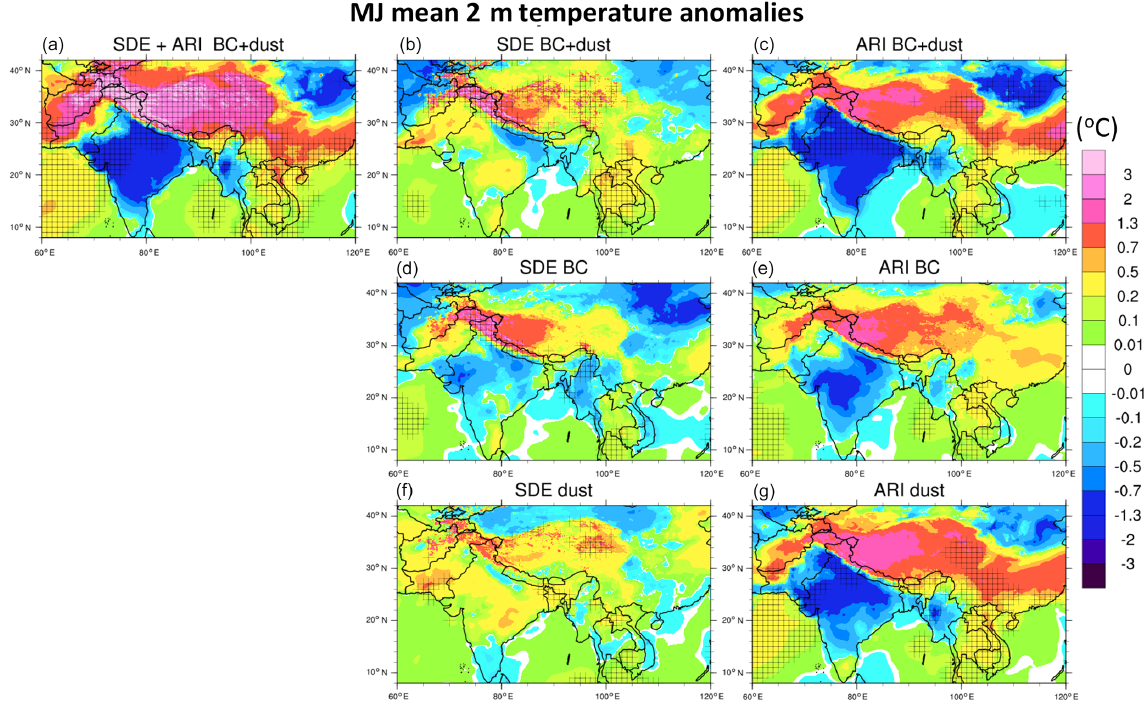
Figure 6. May–June mean 2m temperature ( T 2) anomalies ( ◦ C) due to (a) BCD-induced SDE + ARI, (b) BCD-induced SDE, (c) BCD- induced ARI (d) BC-induced SDE, (e) BC-induced ARI, (f) dust-induced SDE, and (g) dust-induced ARI. Hatching marks denote areas with t values of 0.9 and greater, which have been interpolated to a 1 ◦ mesh for presentation. It is noted that, inside the 1 ◦ zone, there might be as many as 64 grid points that are characterized by statistically significant